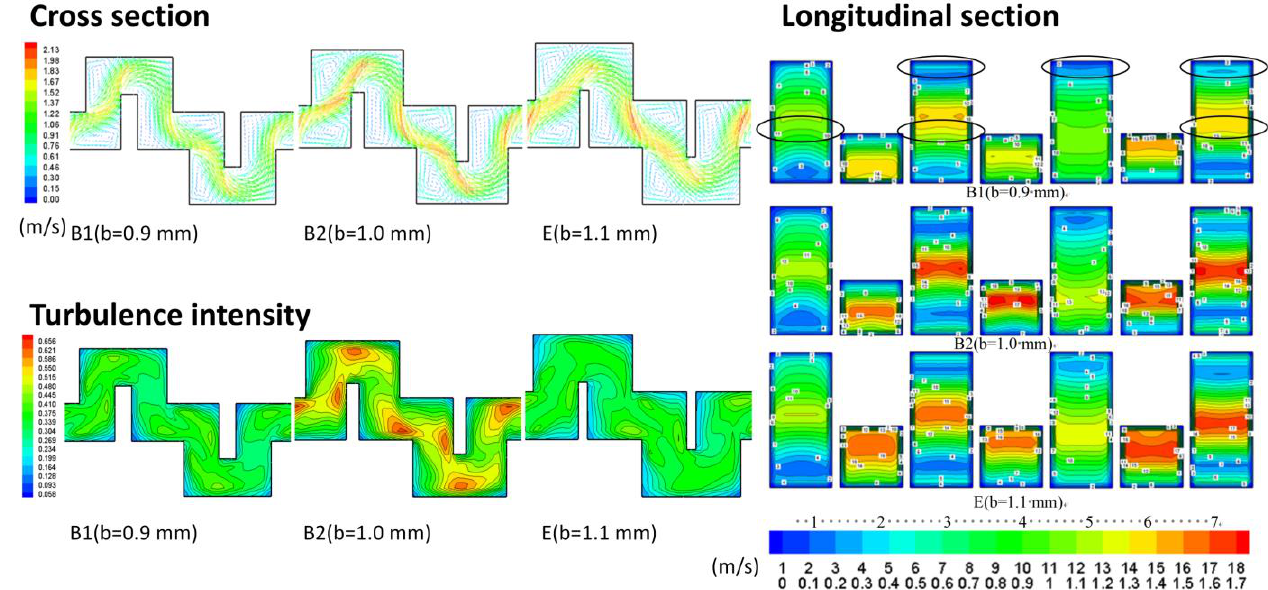
Figure 8. Analysis of transverse and longitudinal velocity field distribution and turbulence intensity characteristics of flow paths of different widths.